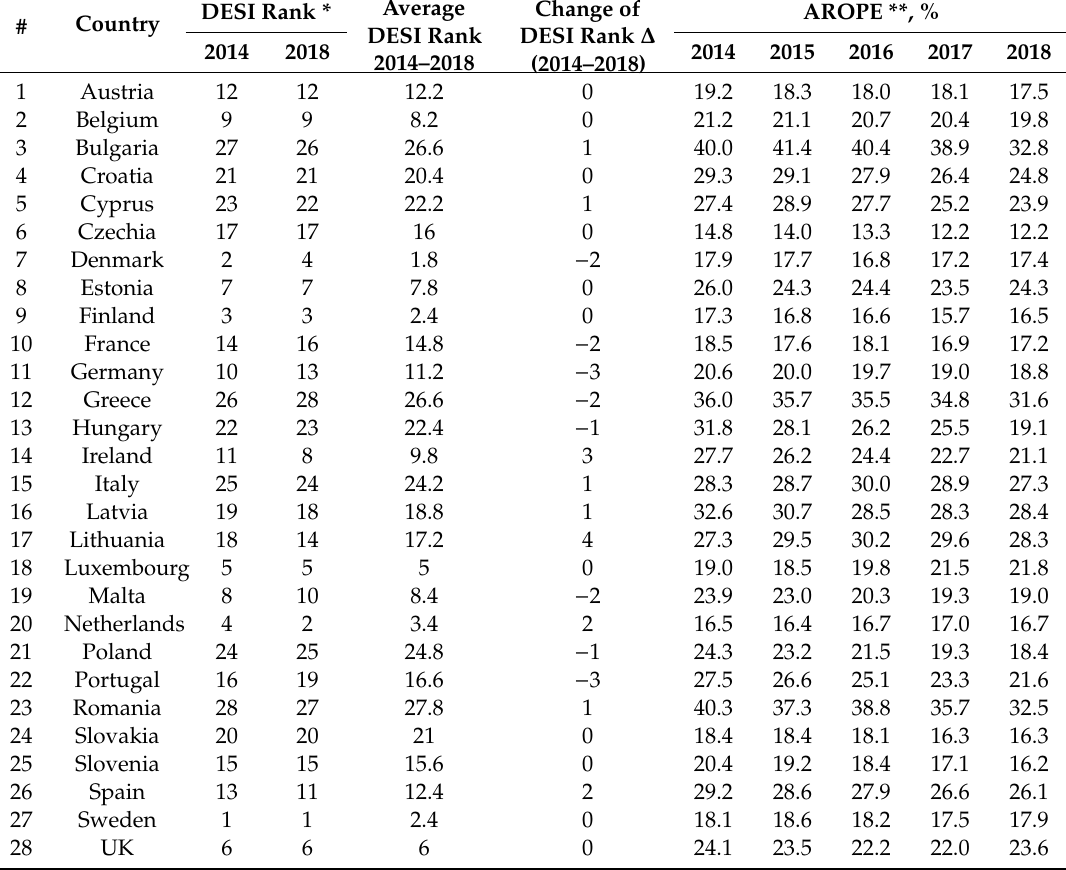
Table 6. People at risk of poverty or social exclusion (AROPE) against the DESI Rank in 2014–2018. DESI Rank